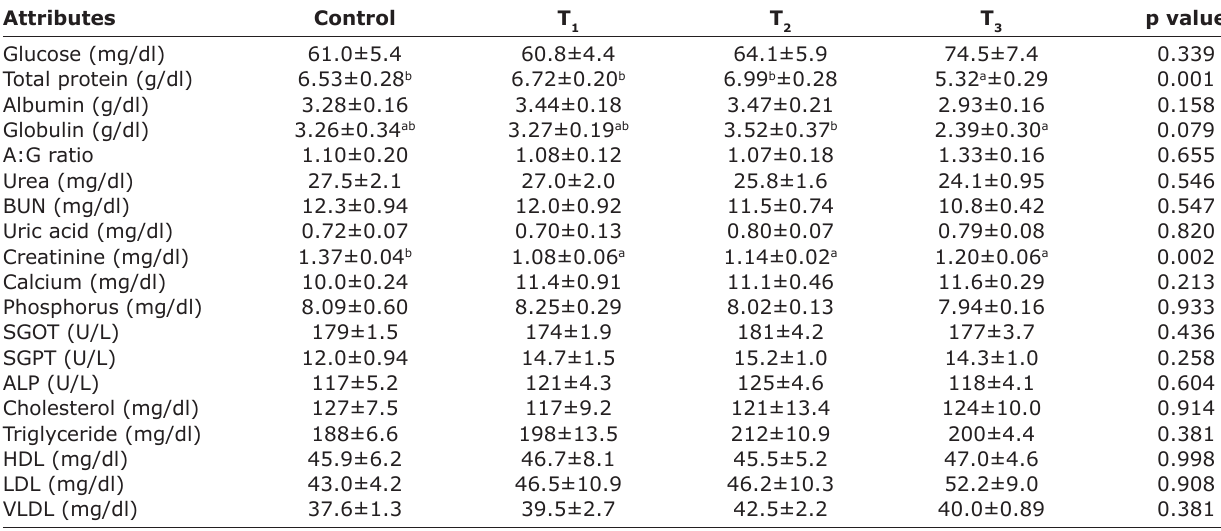
Table-3: Effect of feeding A. nilotica pod meal on blood biochemical profile of goats.